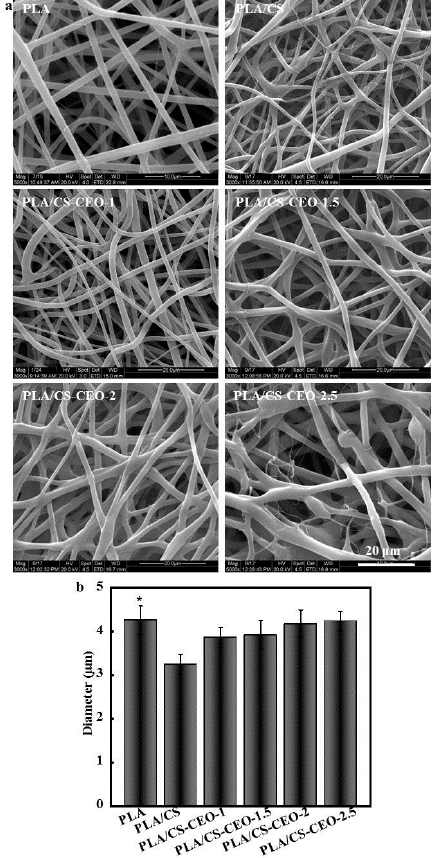
Figure 3. ( a ) Scanning electron micrographs of electrospun PLA/CS-CEO fibers; and ( b ) averaged diameter of PLA/CS-CEO fibers. ( n = 5, * means p < 0.05).